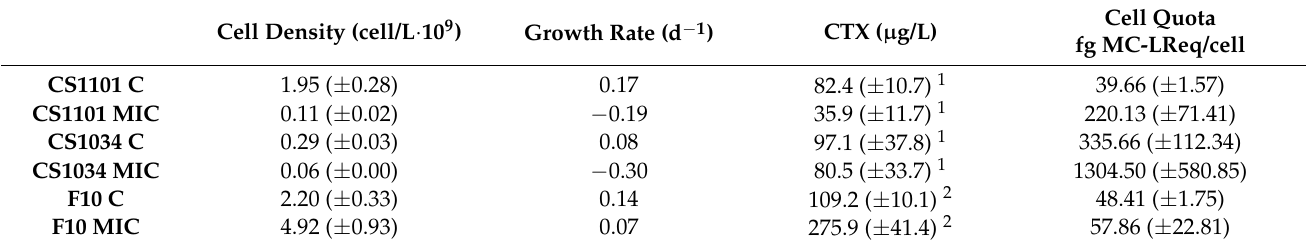
CS1101 R. raciborskii , CS1034 C. ovalisporum , F10 P. rubescens . C = control, MIC = treated systems. Average of three replicates ± SD. 1 = cylindrospermopsin; 2 =